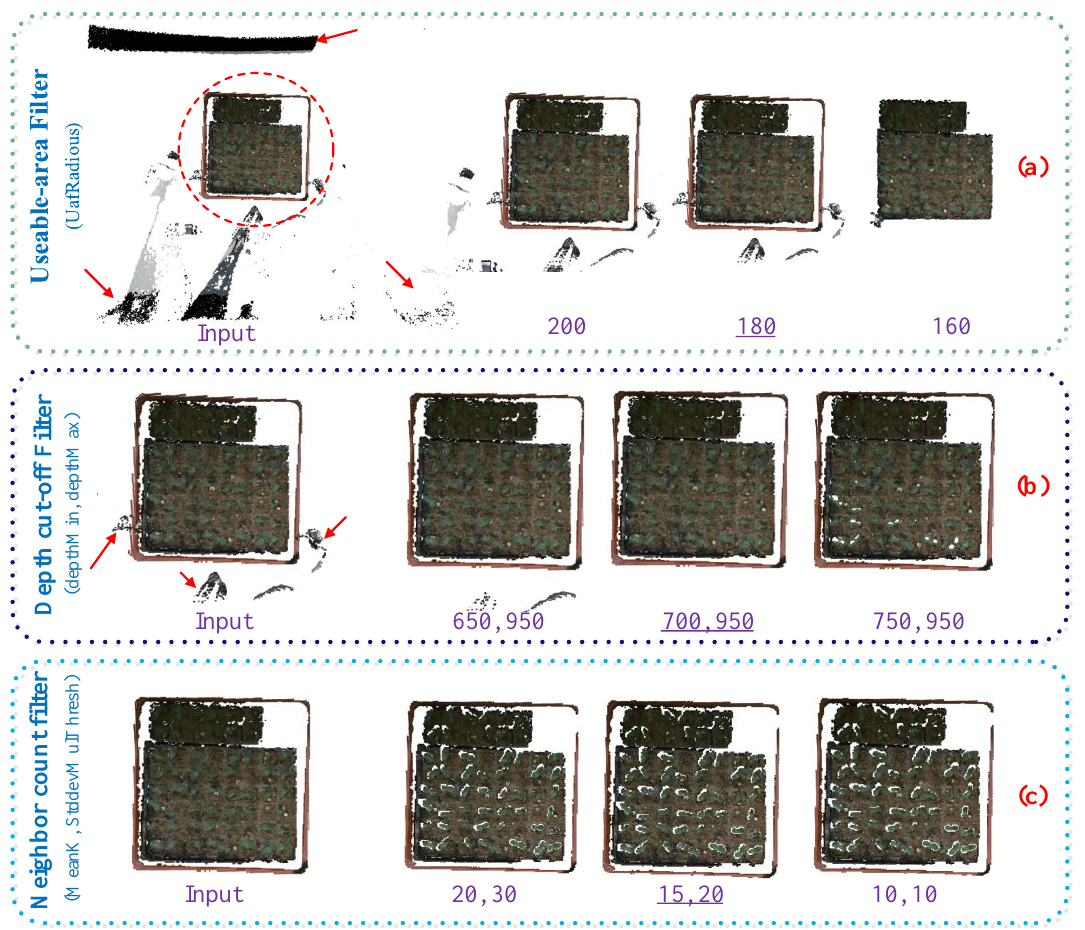
Figure 3. Key parameter optimization of filtering algorithms. In each row ( a – c ), the left title is the filtering algorithm name with its key parameter(s) in parentheses, then follows the input point clouds and the results under three different parameter(s) settings, and the optimized values are underlined.